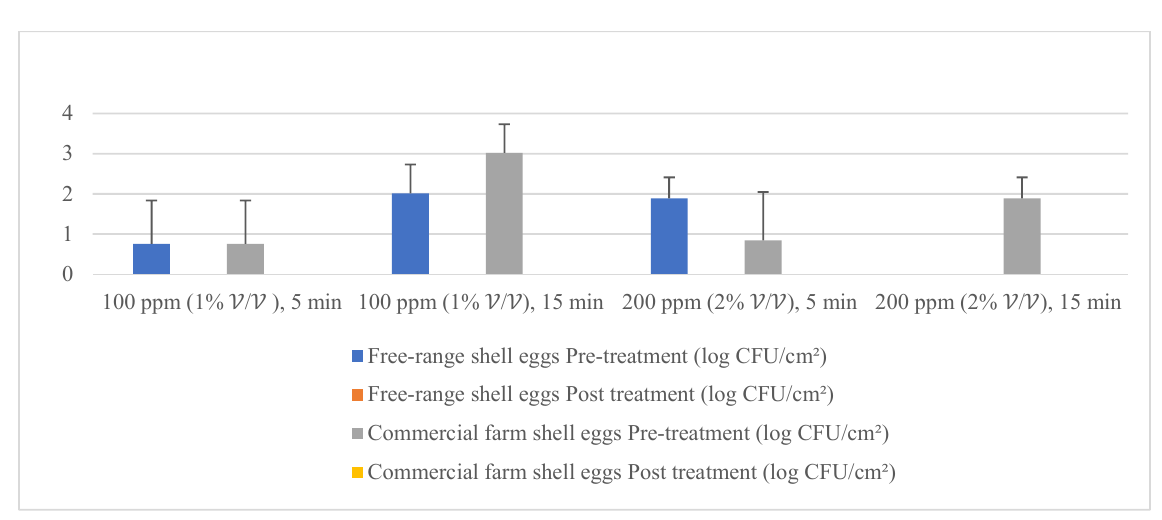
Figure 5. Mean population of yeasts (pre- and post-treatment) for free-range shell eggs and commercial farm shell eggs.